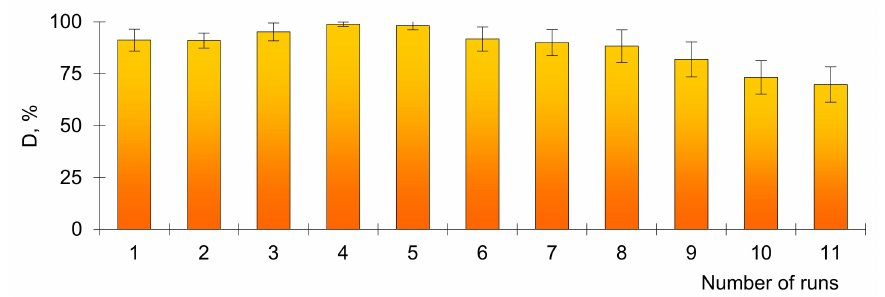
Figure 6. Change in the degradation efficiency D of MB (0.1 mg/L) dye for several consecutive